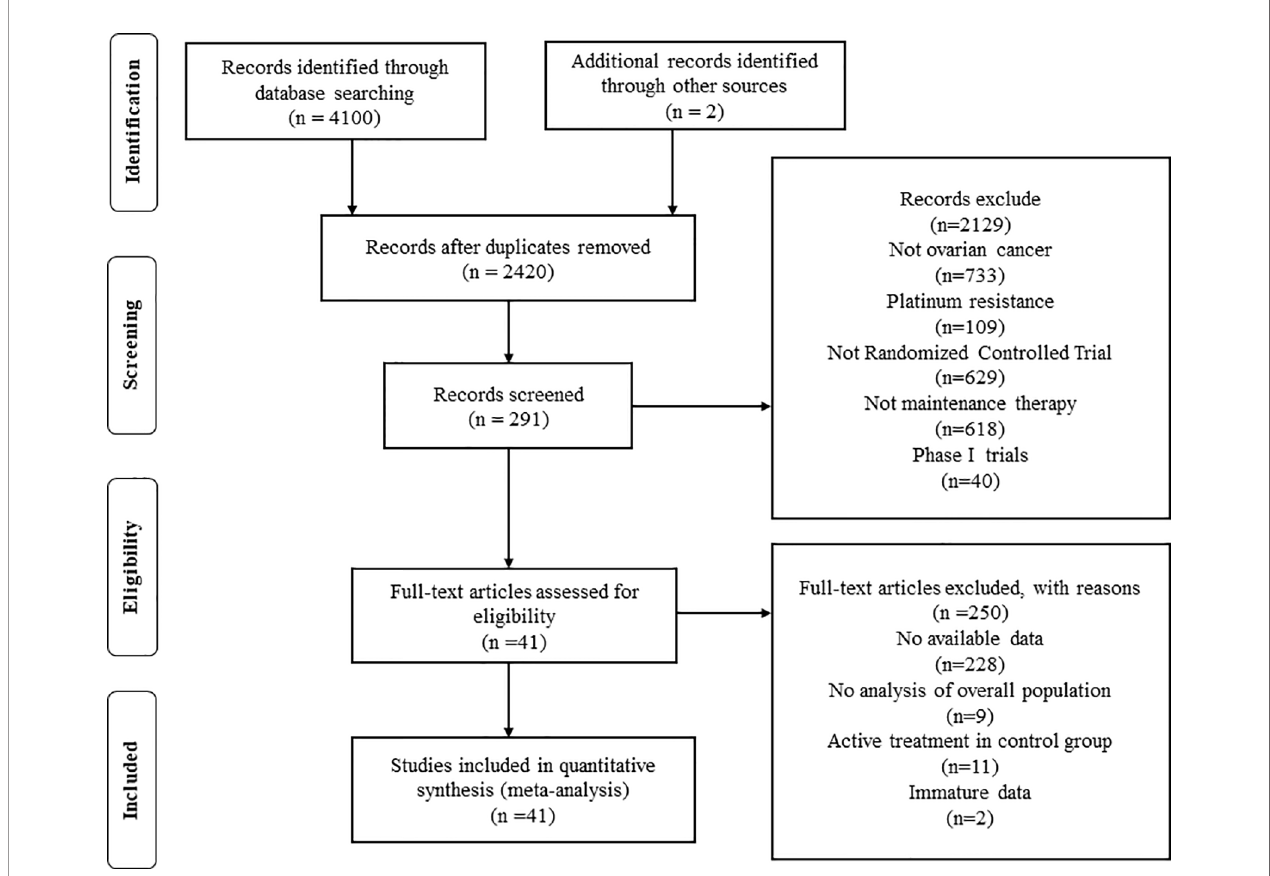
FIGURE 1 | Preferred Reporting Items for Systematic Review and Meta-analysis fl ow chart of the study selection